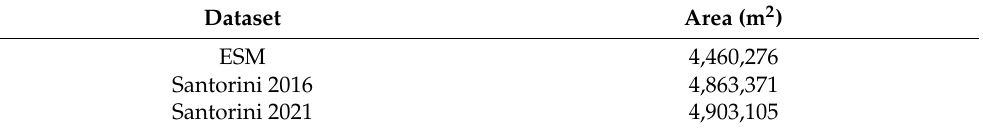
Table 5. Comparison of ESM with ML product for Thira for 2016 and its spatial expansion to